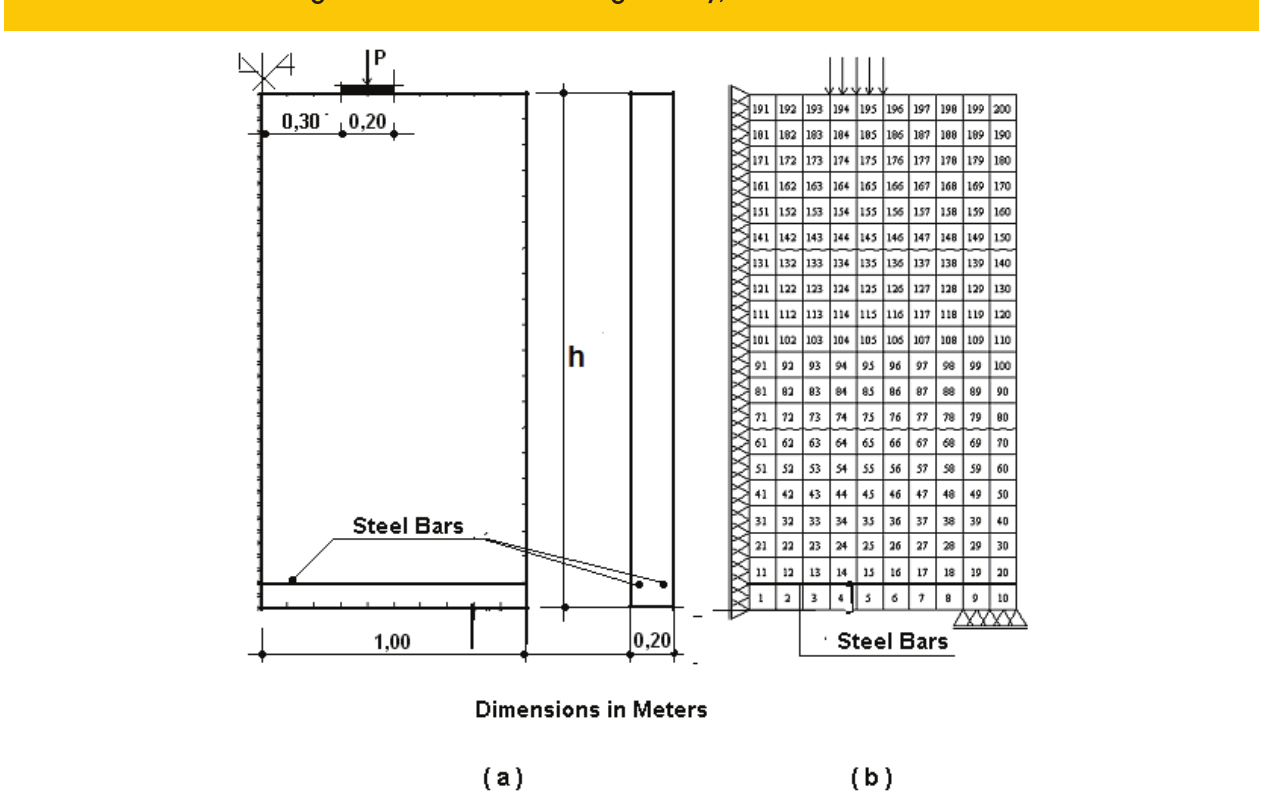
Figure 5 – Studied models: a-geometry; b-finite element Mesh